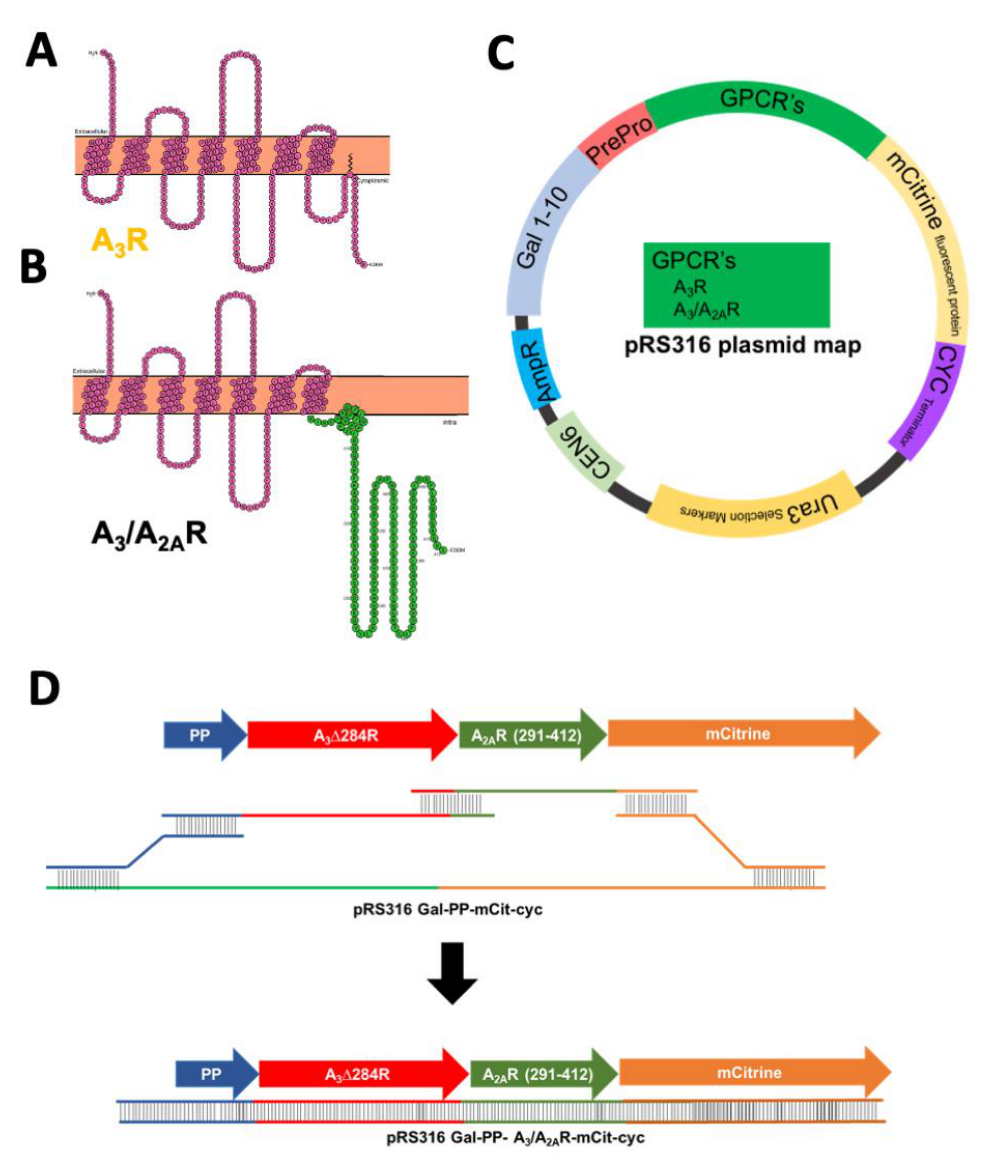
Figure 1. Snake plot for full-length human wild-type A 3 R ( A ) and chimeric A 3 / A 2A R ( B ), where individual circles represent amino acids. Transmembrane helices are evident in the solid orange-colored representation of the plasma membrane. ( C ) Plasmid map for yeast expression vector pRS316- GAL 1–10 -PP-receptor-mCit-cyc t . Each receptor construct contains the GAL 1–10 promoter [31], an N-terminal leader sequence (PrePro [32], PP) to aid in ER tra ffi cking, and a C-terminal mCitrine fluorescent protein (mCit) to aid in detection of receptor levels. ( D ) Schematic for homologous recombination strategy to generate chimeric A 3 / A 2A R construct in yeast expression plasmids.